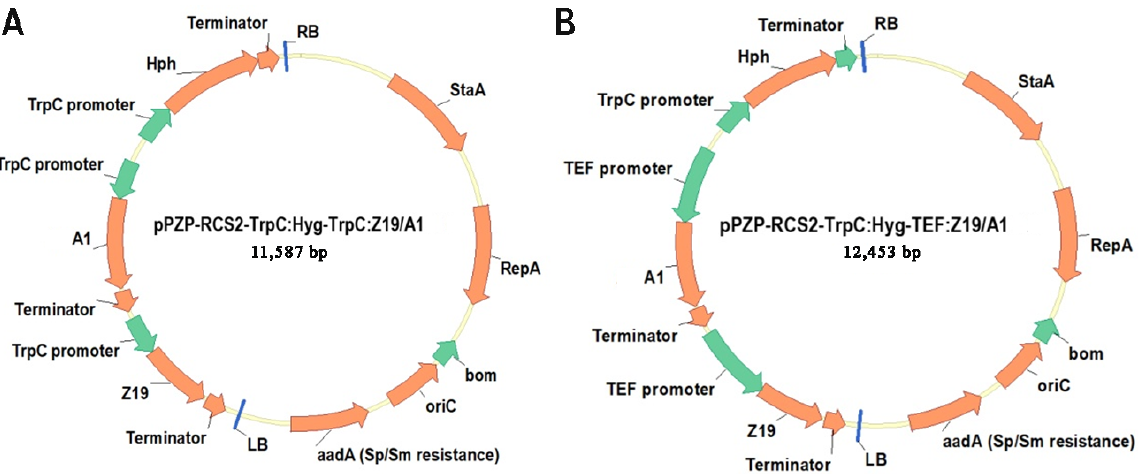
Figure 1. Binary vectors pPZP-RCS2-TrpC:Hyg-TrpC:Z19/A1 ( A ) and pPZP-RCS2-TrpC:Hyg-TEF:Z19/A1 ( B ) carrying genes for synthesis of Z19 and A1 under the control of P trpC and P tef promoters. P tef